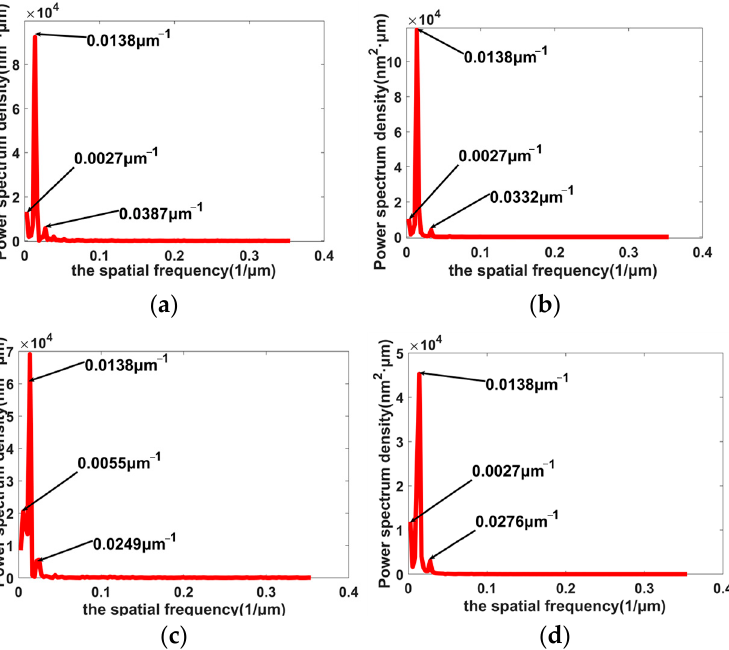
Figure 11. PSD of the simulation and experiment profiles: ( a ) PSD of experiment profiles with ap = 9 μ m, n = 1300 r/min, and f = 12 μ m/r; ( b ) PSD of simulation profiles with ap = 9 μ m, n = 1300 r/min, and f = 12 μ m/r; ( c ) PSD of experiment profiles with ap = 6 μ m, n = 1400 r/min, and f = 14 μ m/r; ( d ) PSD of simulation profiles with ap = 6 μ m, n = 1400 r/min, and f = 14 μ